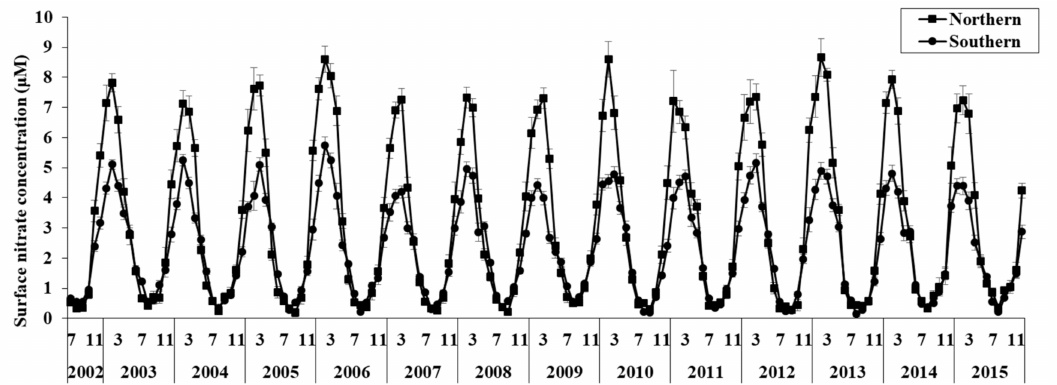
Figure 5. Time series of monthly values in Sea Surface Nitrate (SSN) for the northern and southern East/Japan Sea (EJS) from July 2002 to December